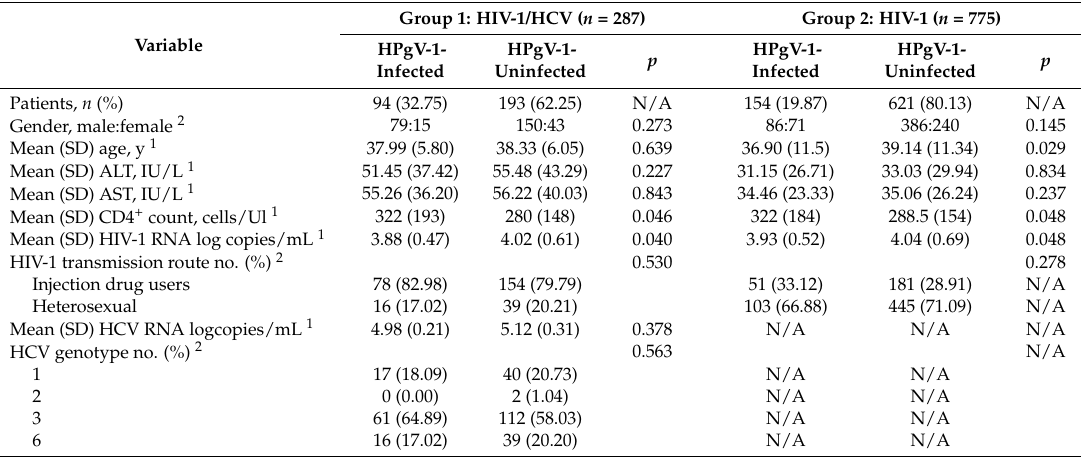
Table 1. Differences between HPgV-1-infected and HPgV-1-uninfected patients among HIV-1-infected individuals with or without HCV.